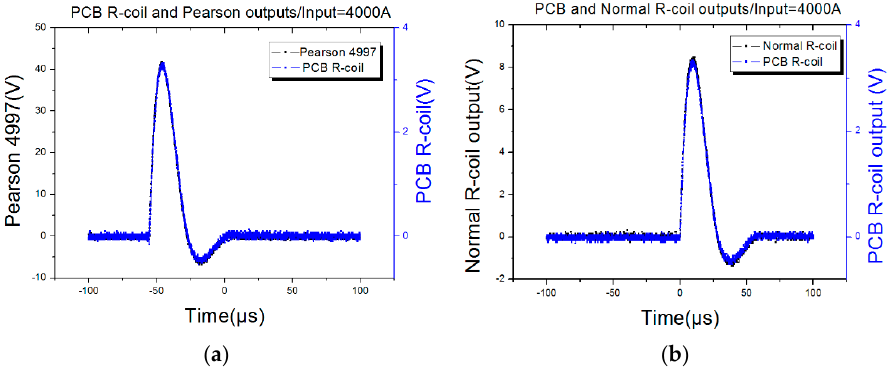
Figure 18. Output waveforms of 8–20 μ s impulse current. ( a ) PCB R-coil and Pearson output waveforms; ( b ) PCB and Normal R-coil output waveforms. Table 10. Outputs of different sensors.